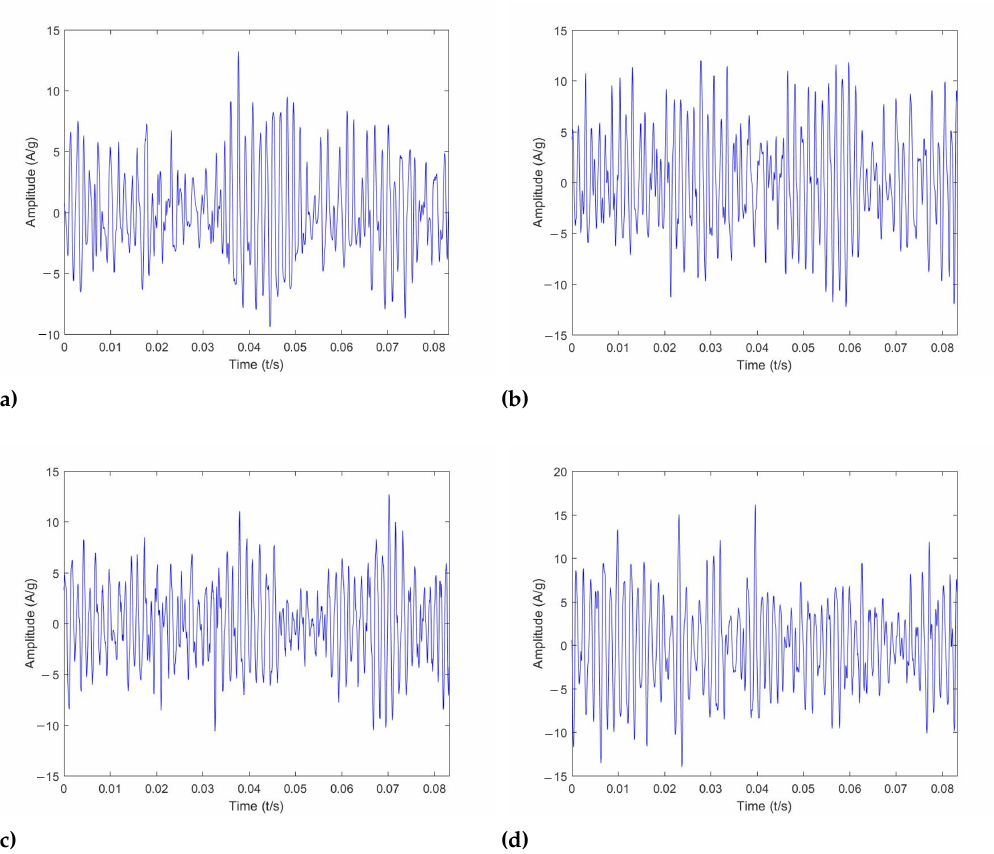
Figure 10. The test bearing with inner race fault.